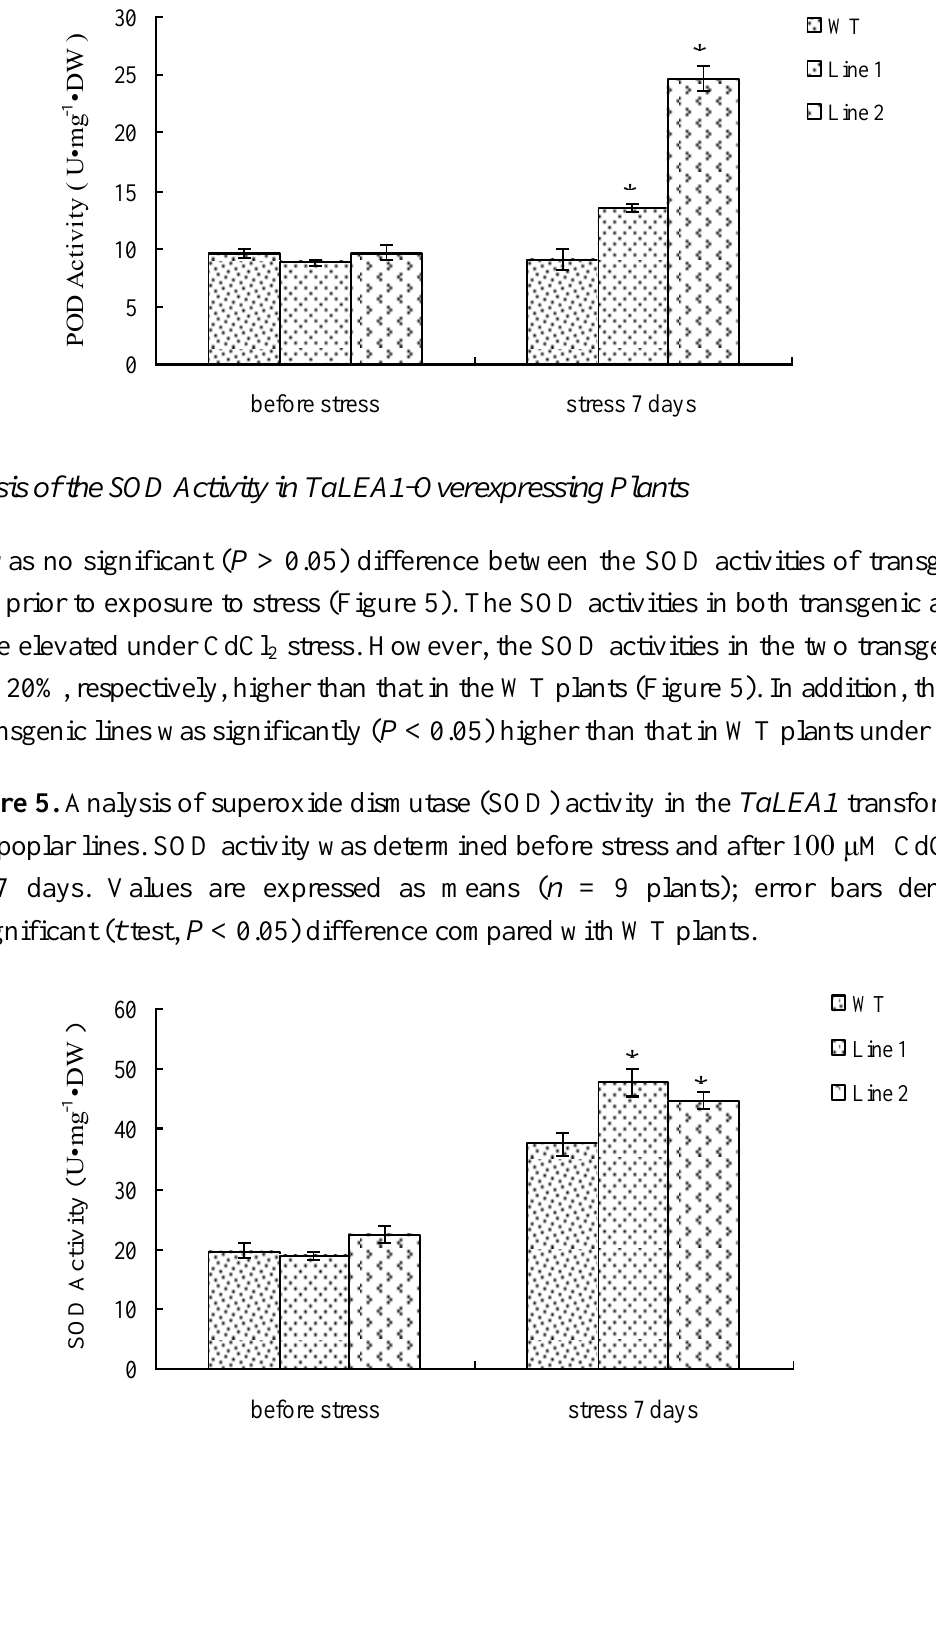
stress for 7 days. 2